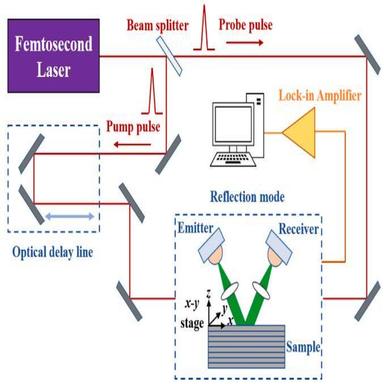
Schematic diagram of the reflection THz TOFT experiment.